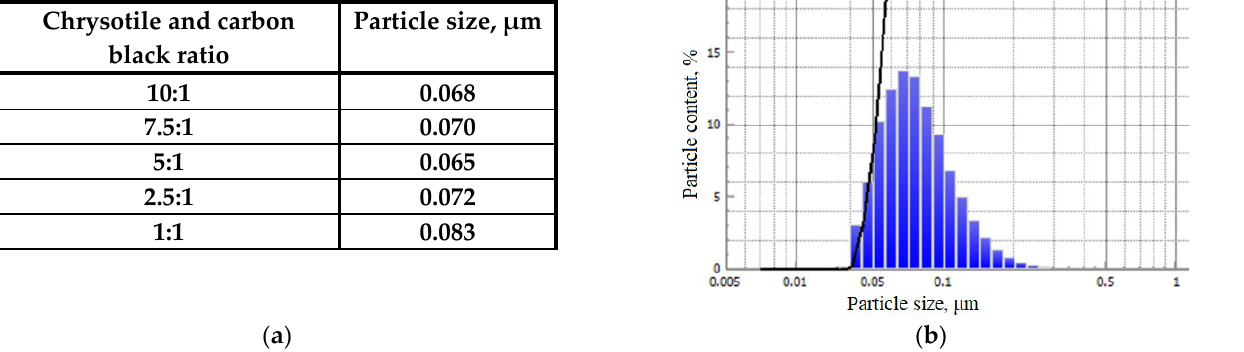
Figure 3. Particle size distribution in the complex additive: ( a ) at different additives ratios; ( b ) at chrysotile to carbon black ratio equal to 5:1.